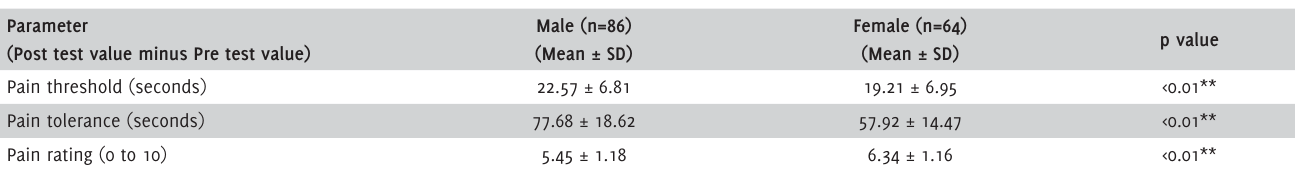
*p<0.05-statistically significant, **p<0.01-highly significant.